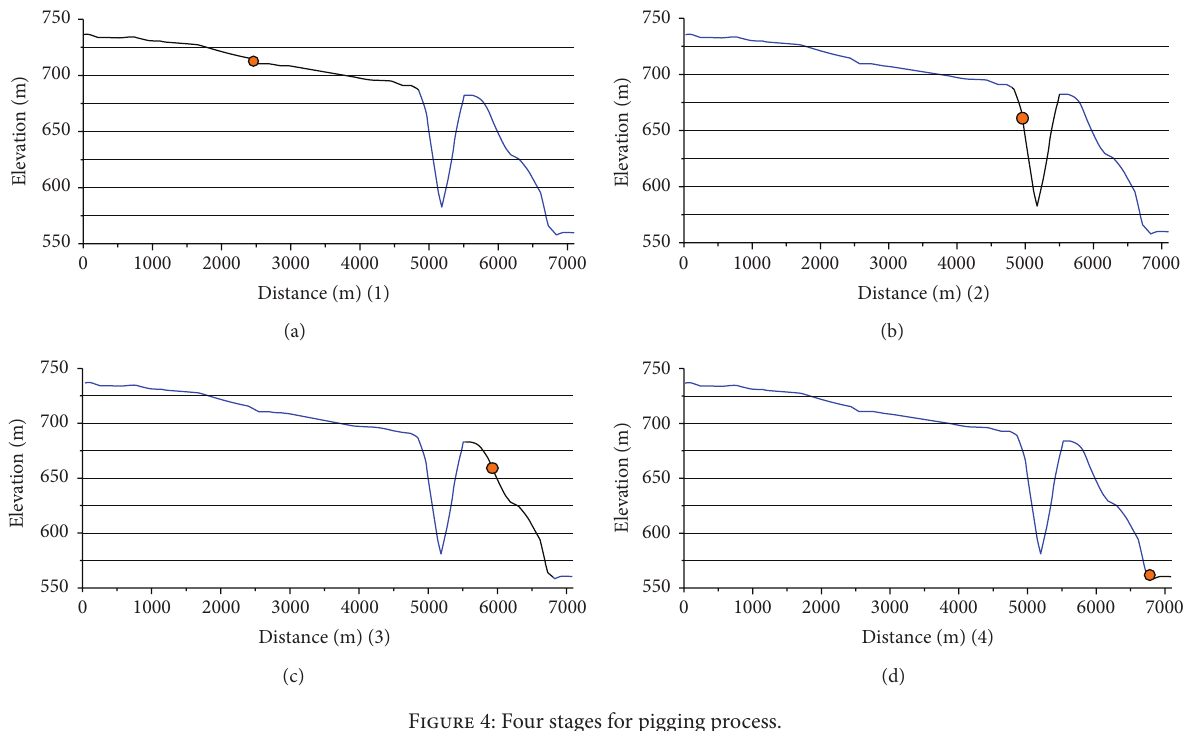
Figure 4: Four stages for pigging process.